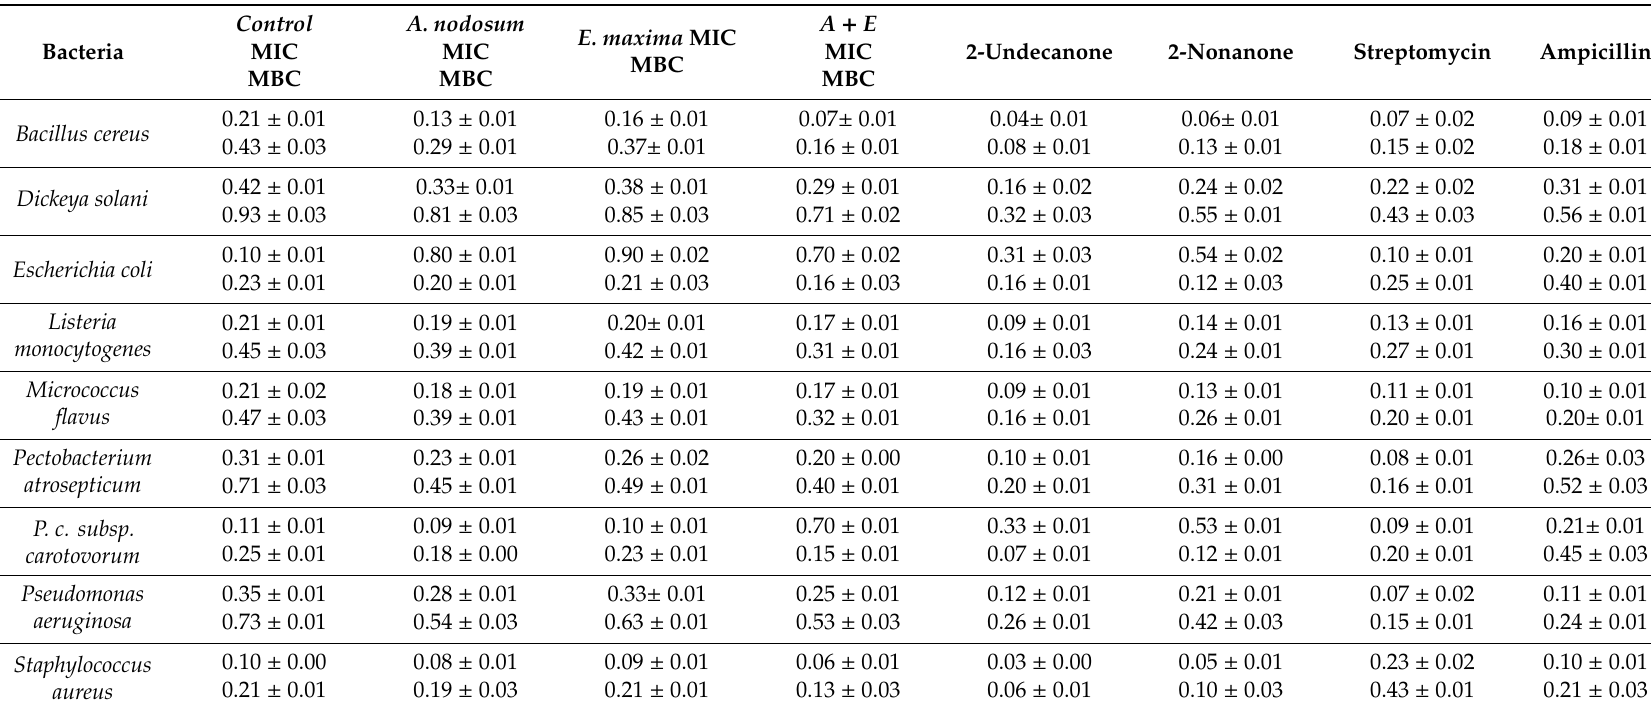
Table 3. Minimum inhibitory (MIC, mg mL − 1 ) and bactericidal concentrations (MBC, mg mL − 1 ) of R. graveolens EOs as a ff ected by SWE